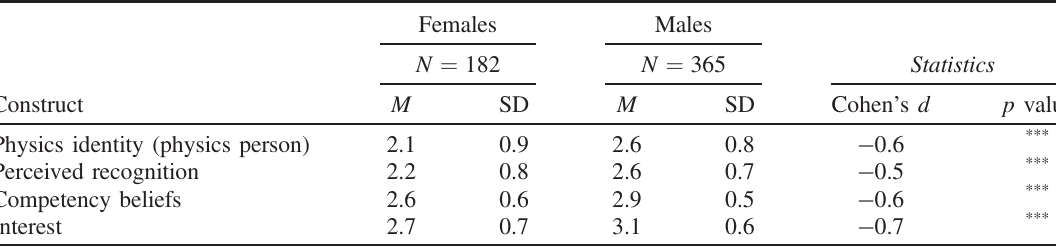
TABLE II. Descriptive statistics for female and male students in which M stands for construct mean value, SD is the standard deviation, and N is the number of students. Effect sizes and p values are presented in the rightmost column where *** indicates p < 0 . 001 and the minus sign indicates male students have higher scores than female students.